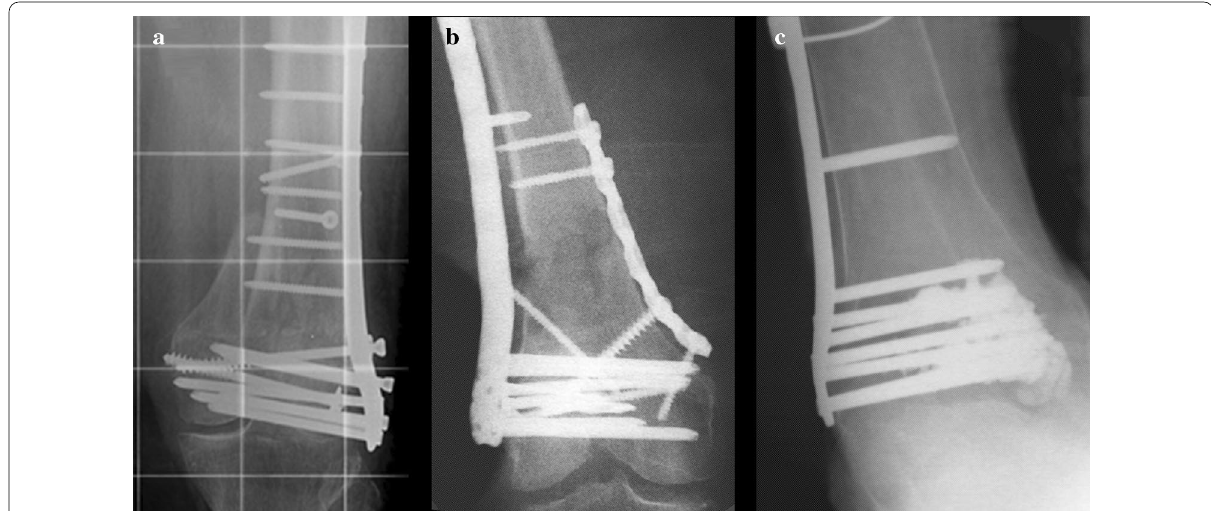
Fig. 1 Distal femoral fracture cases. a X-ray of a distal femoral fracture after locked plating in anteroposterior projection; construct failure due to screw loosening and secondary loss of reduction is apparent. b X-ray of a distal femoral fracture treated with double plating to increase construct stability. c X-ray of a severe osteoporotic distal femoral fracture with locked plating and screw augmentation to enhance implant anchorage and construct